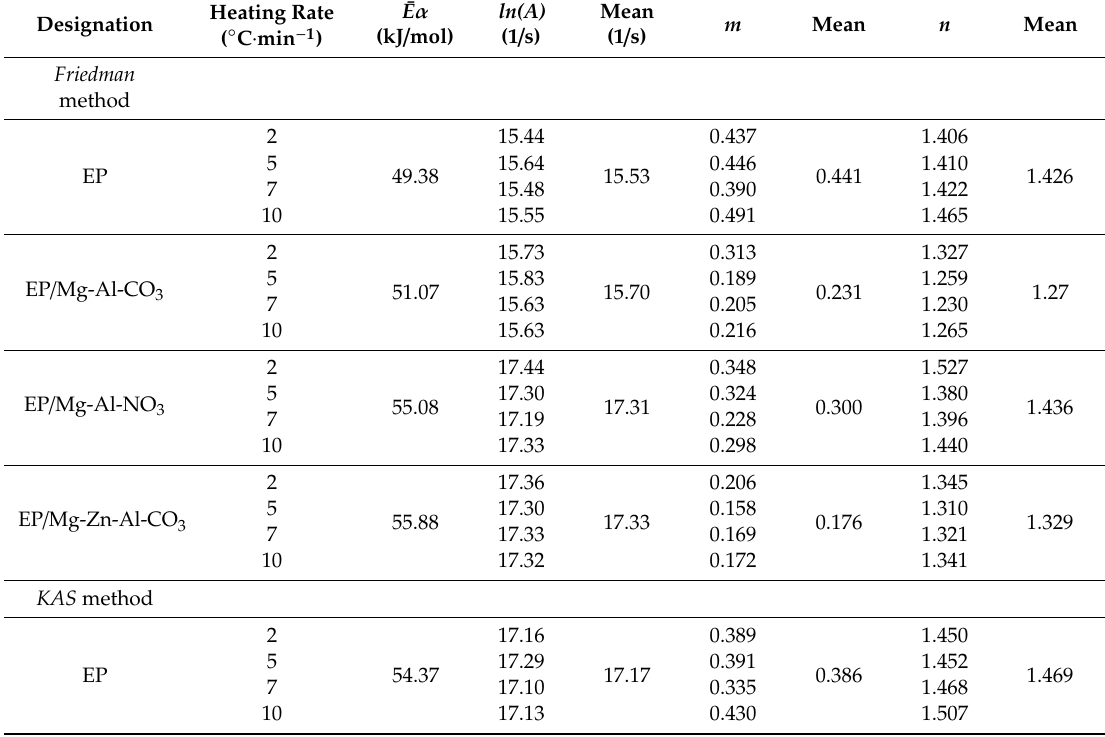
Table 2. The kinetic parameters obtained for the curing of the prepared samples based on the Friedman and KAS methods at di ff erent heating